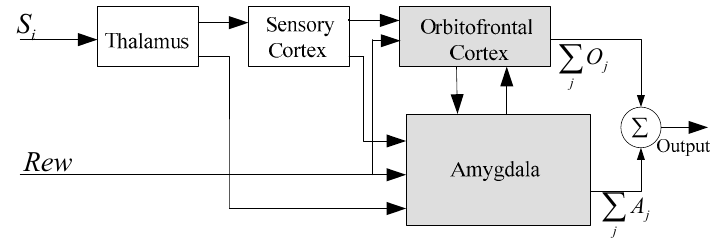
Figure 2. Framework of the amygdala-orbitofrontal model .